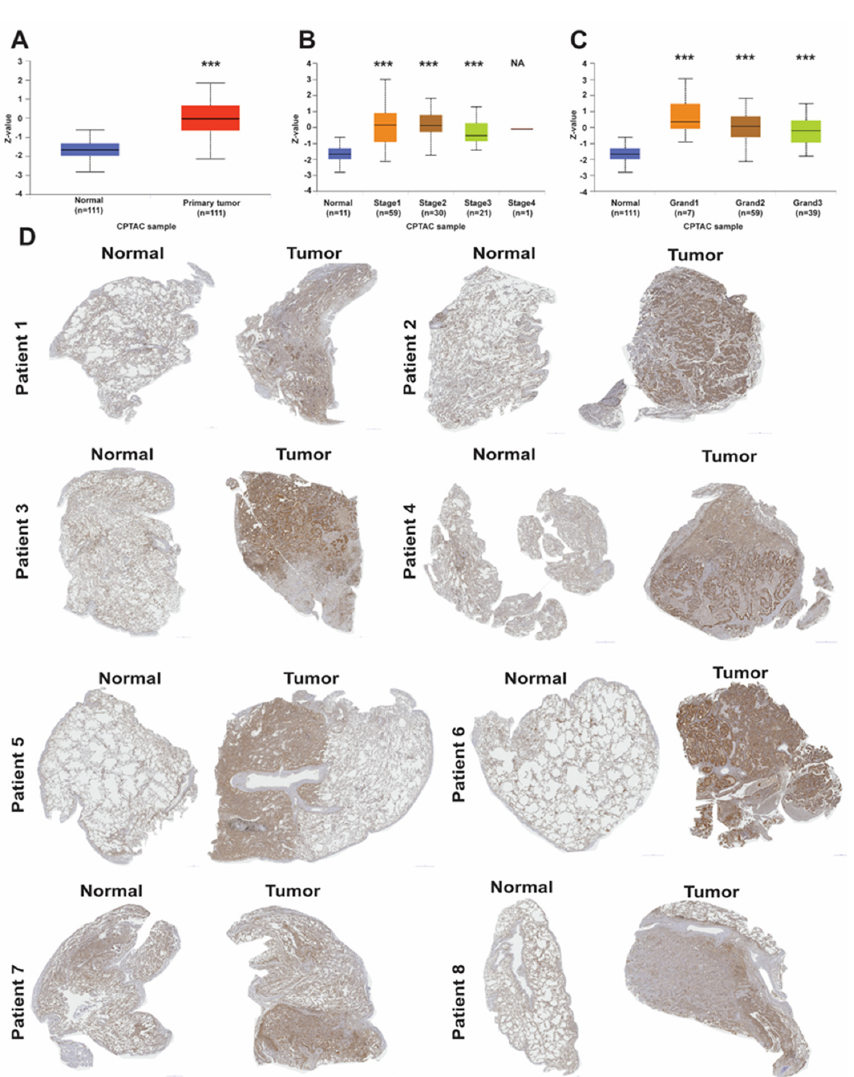
Figure 2. The protein expression of LAD1 in LUAD. ( A ) LAD1 protein had significantly lower expression levels in normal tissues than in the primary tumors in LUAD from the CPTAC cohort. The protein expression of LAD1 was significantly increased among the tumor stages ( B ) and the tumor grades ( C ) in the CPTAC cohort. The Z-values represent standard deviations from the median across samples for lung cancer. ( D ) Comparison of LAD1 protein expression between paired normal tissues (left) and tumor tissues (right) from the eight in-house LUAD patients by immunohistochemistry (IHC) staining. (***, p < 0.005).